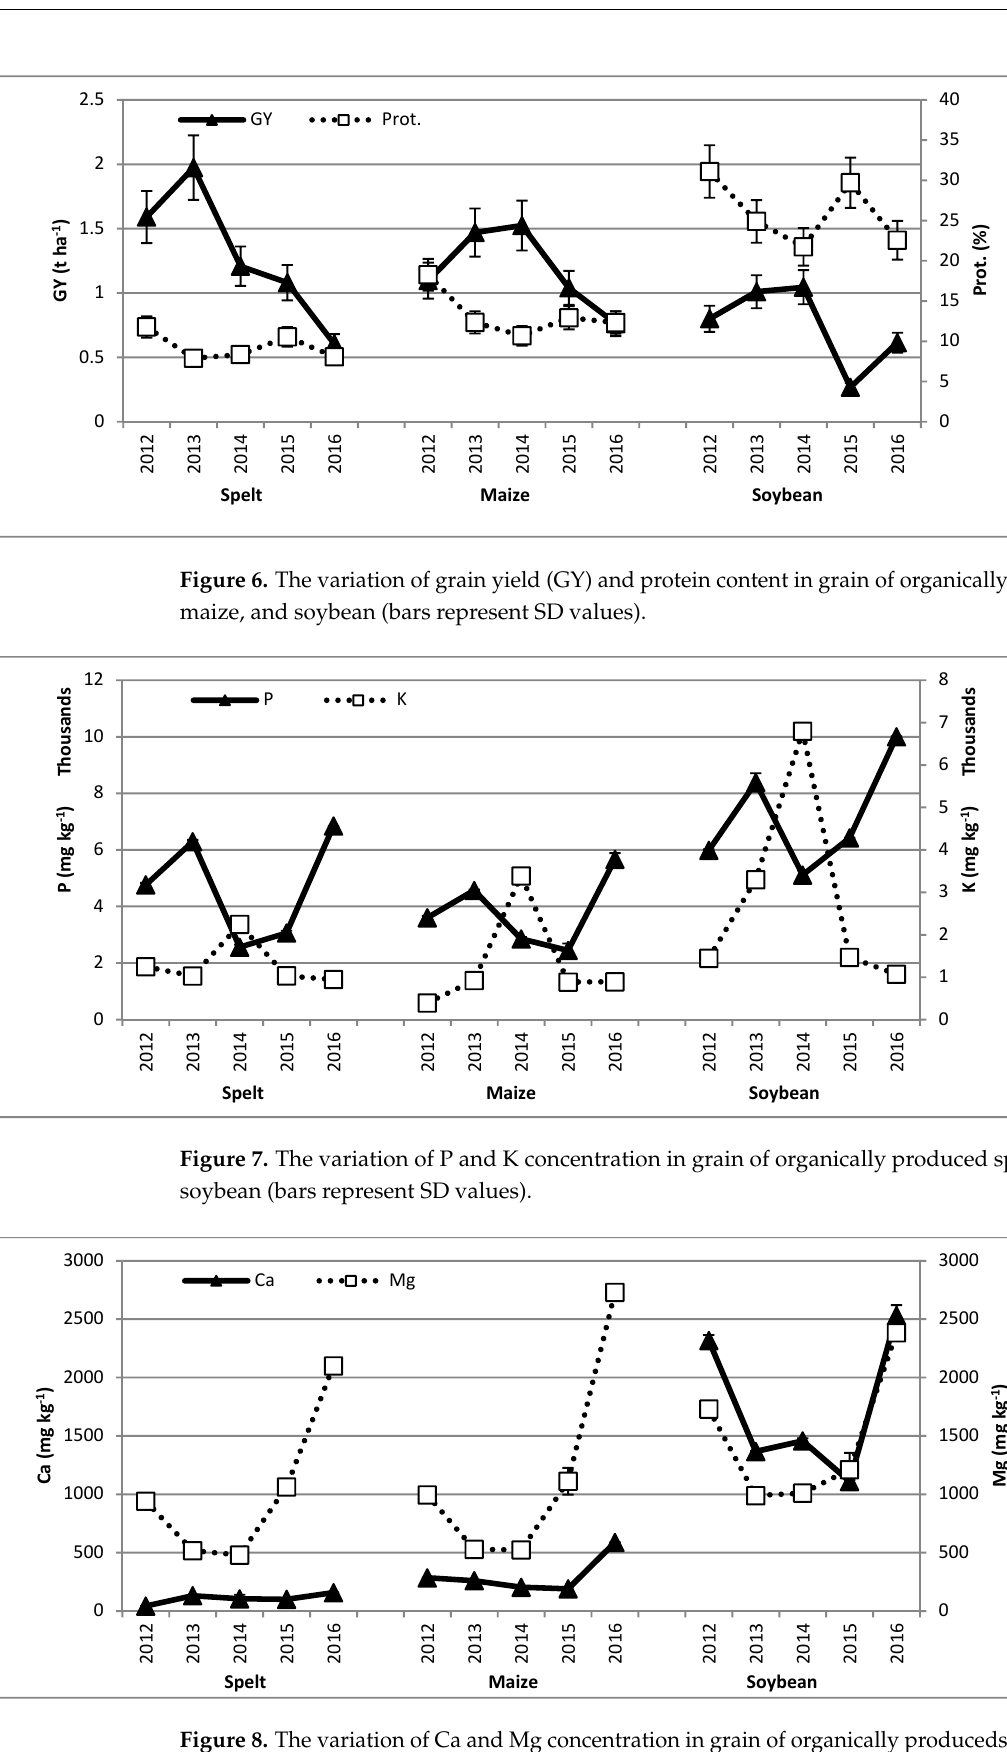
Figure 9. The variation of Fe, Si, and Cu concentration in grain of organically produced spelt, maize, and soybean (bars represent SD values). Figure 10. The variation of Mn and Zn concentration in grain of organically produced spelt, maize, and soybean (bars represent SD values).